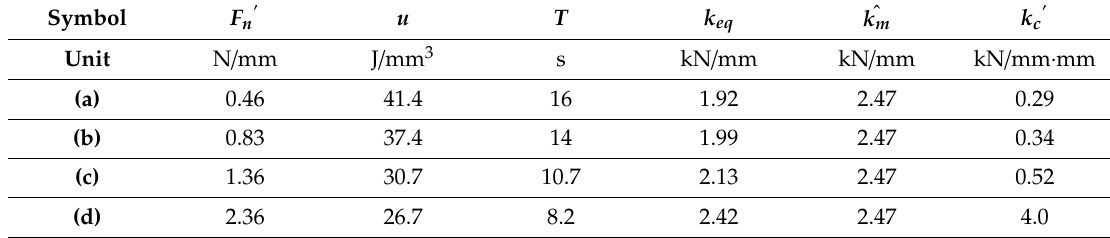
Table 8. Critical parameters obtained by the simulations in Figure